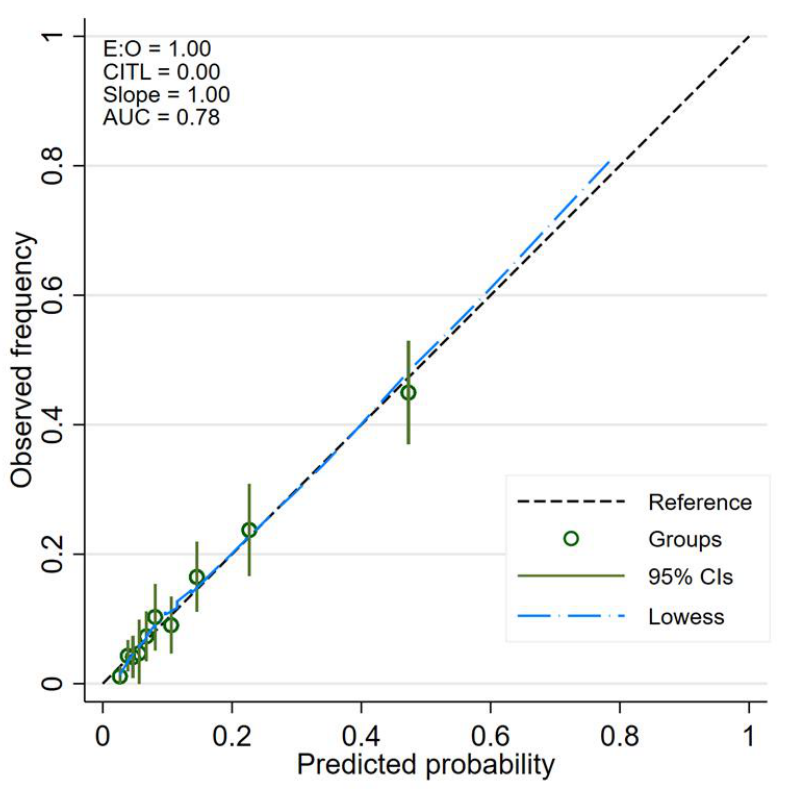
Figure 3. Calibration plot between the score-predicted probability of AKI and observed AKI. Abbreviations: AUC, area under the curve; CIs, confidence intervals; CITL, calibration-in-the-large.